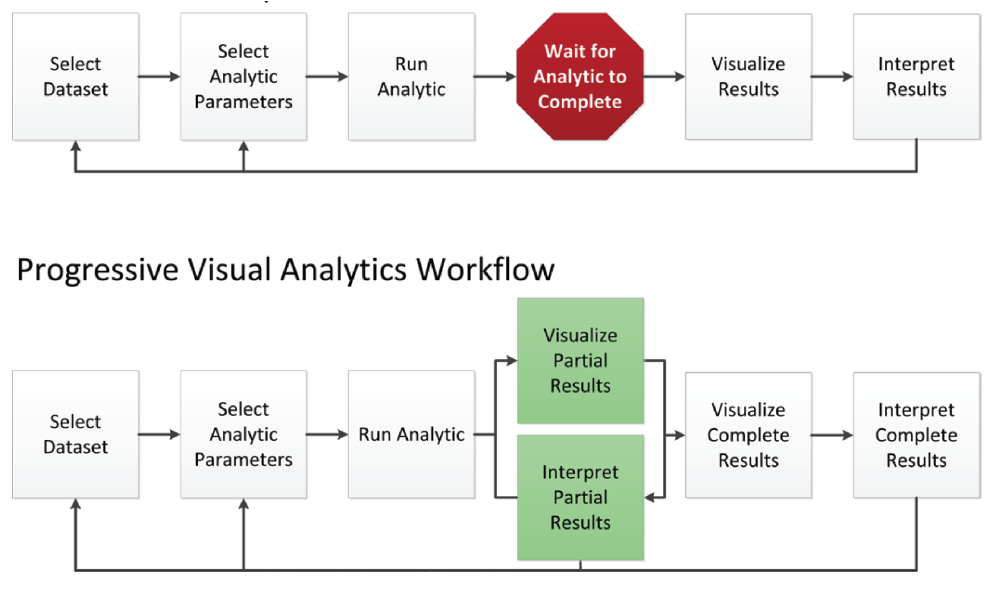
Figure 3. Progressive Visual Analytics (PVA) model proposed by Stolper [49].